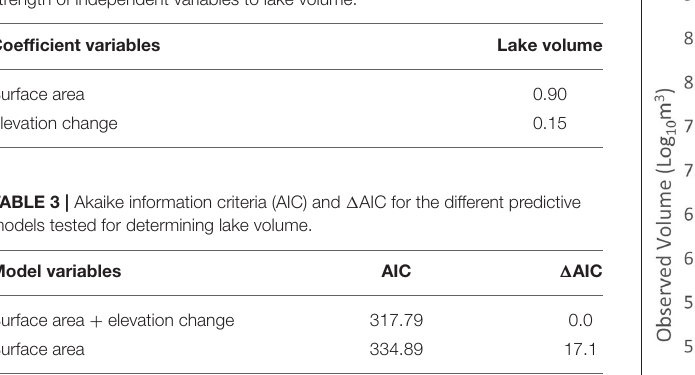
TABLE 2 | Pearson partial correlation coefficient tested to determine correlation strength of independent variables to lake volume.